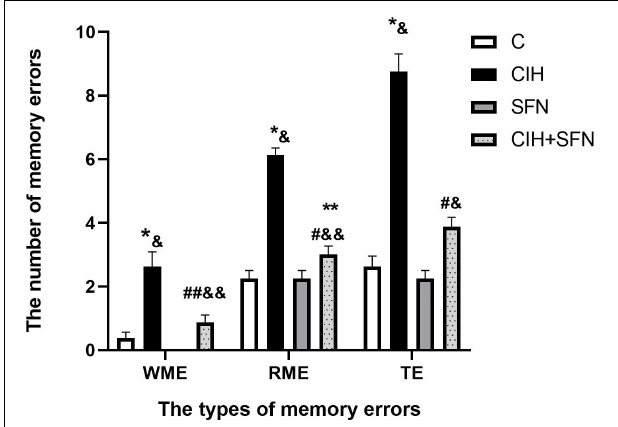
FIGURE 1 | SFN alleviates CIH-induced cognitive dysfunction in the 8-arm radial maze test. The numbers of memory errors of WME, RME, and TE in different groups in 8-arm radial maze test. Graphs display normalized results of mean ± SD for n = 10 and statistical significance (* p ≤ 0.01 vs. C; ** p ≤ 0.05 vs. C; # p ≤ 0.01 vs. CIH; ## p ≤ 0.05 vs. CIH; & p ≤ 0.01 vs. SFN; && p ≤ 0.05 vs. SFN). C, intermittent air; CIH, chronic intermittent hypoxia; SFN, C with SFN treatment; CIH + SFN, CIH with SFN treatment; WME, working memory errors; RME, reference memory errors; TE, total